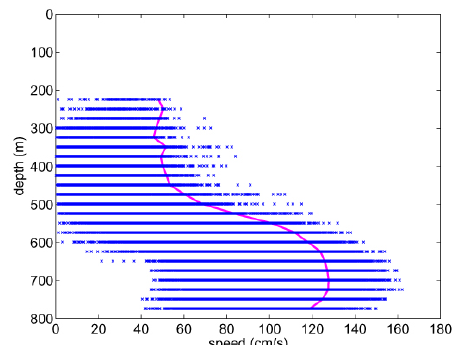
Fig. 9. Vertical variation of the threshold (0.95 quantile) in sector 300/330 ◦ at location FB. In blue all the available data and in ma- genta the threshold.